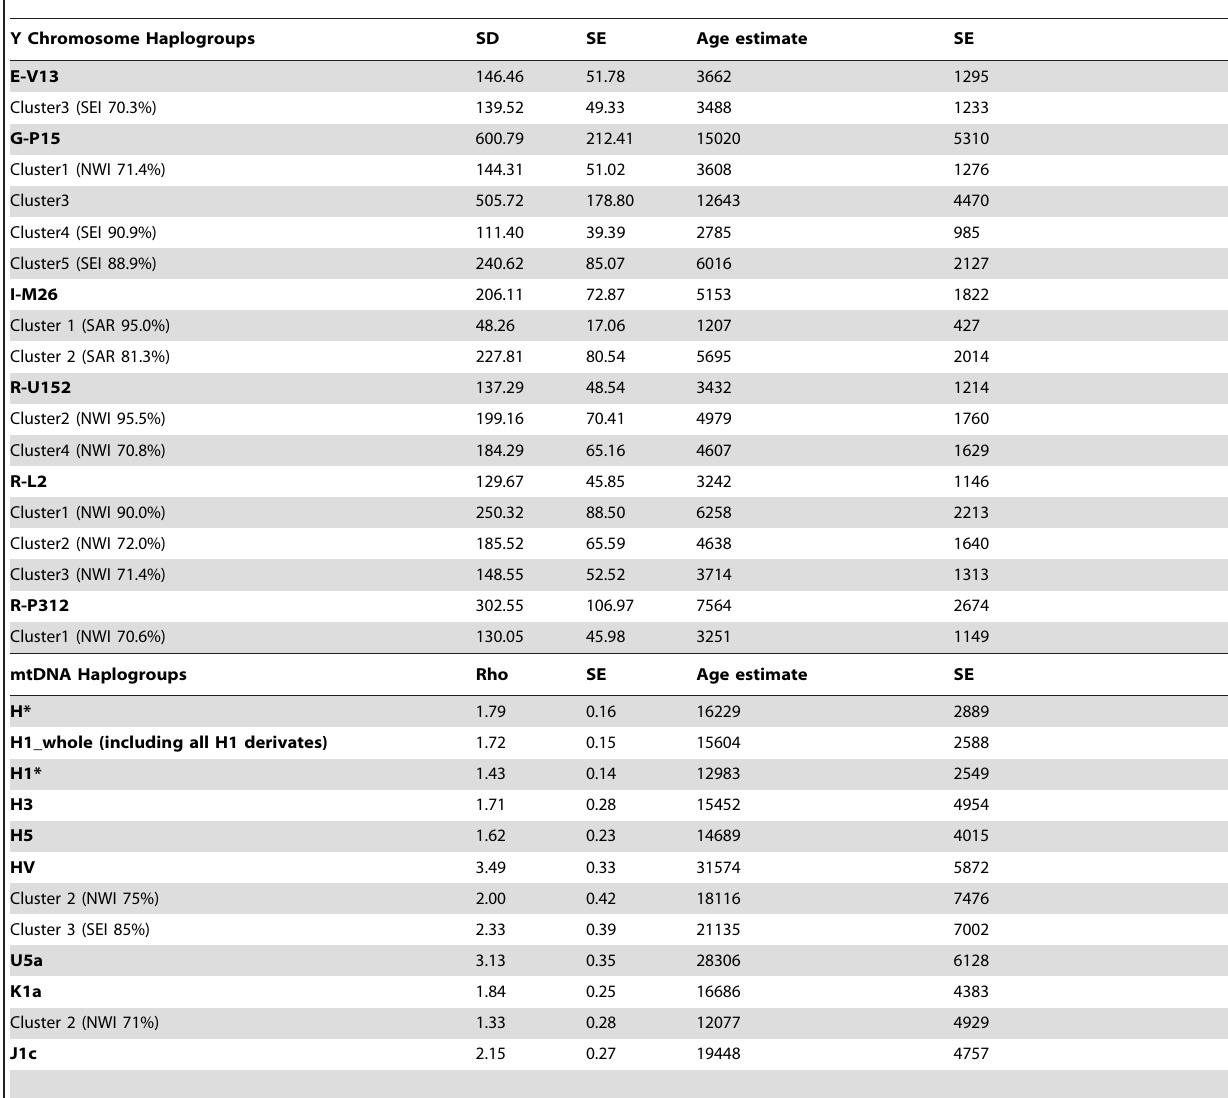
Table 2. Age estimates (in YBP) of STR and HVS variation for the most common haplogroups in the Italian data set.